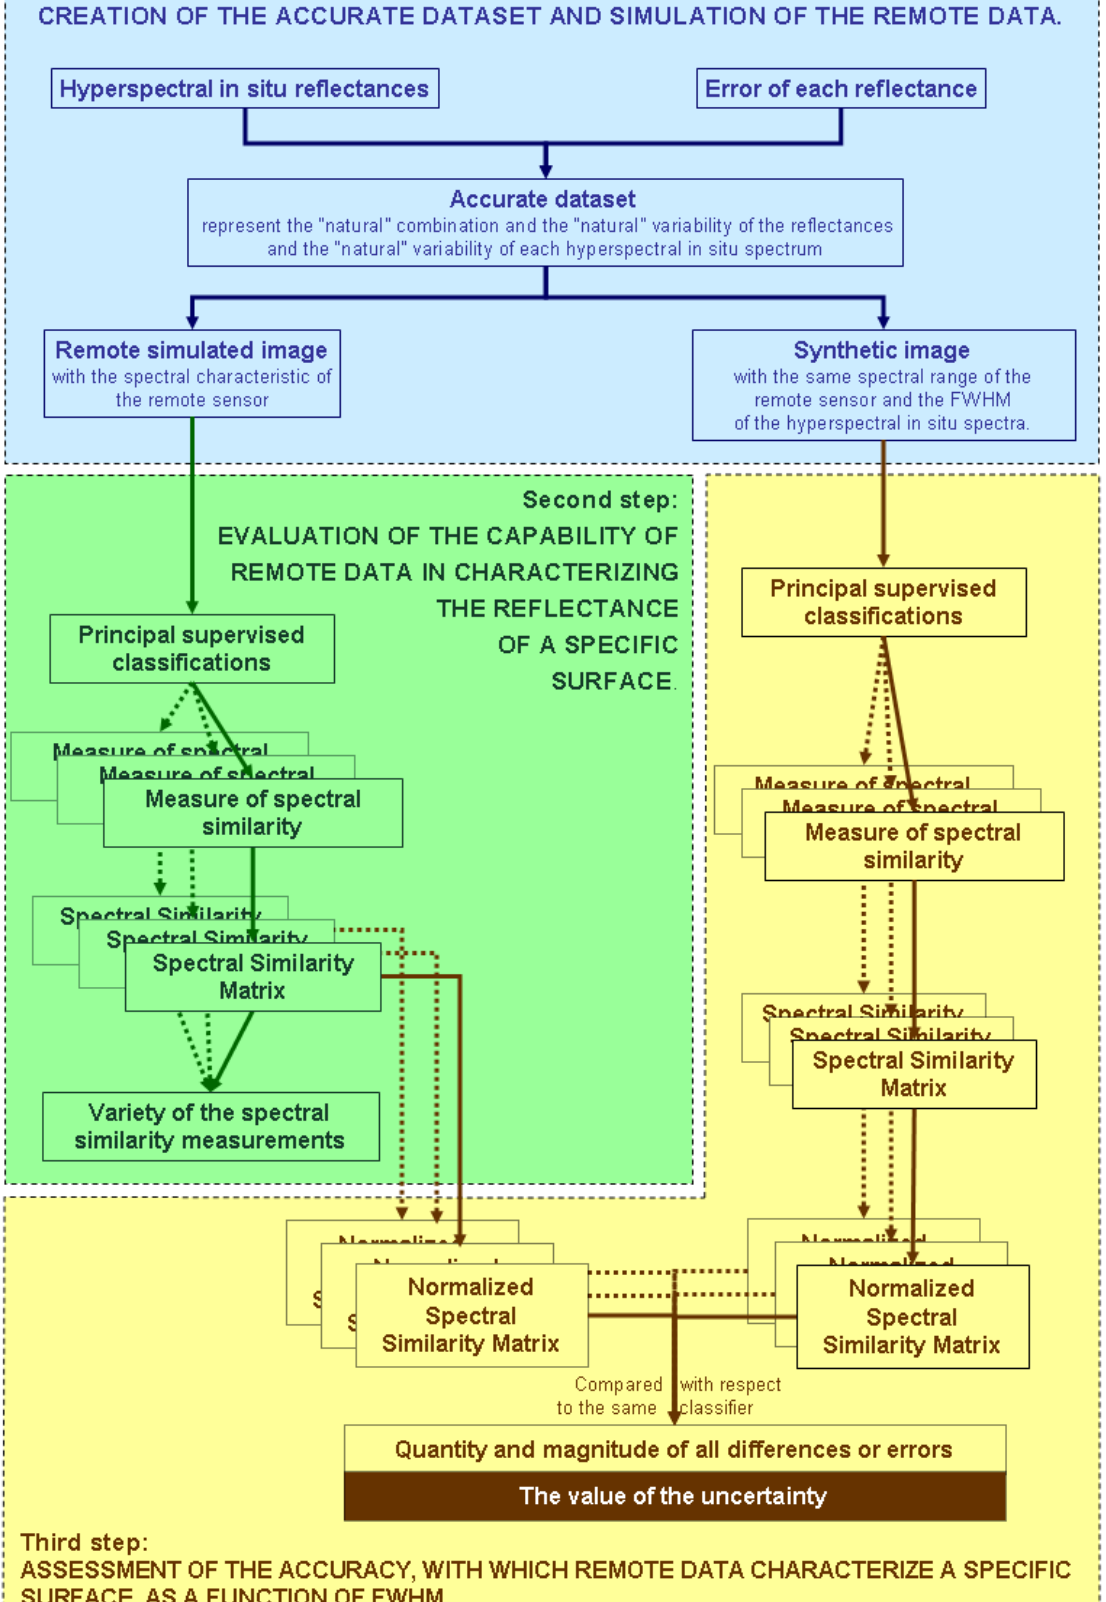
Figure 2. Flow chart of the proposed